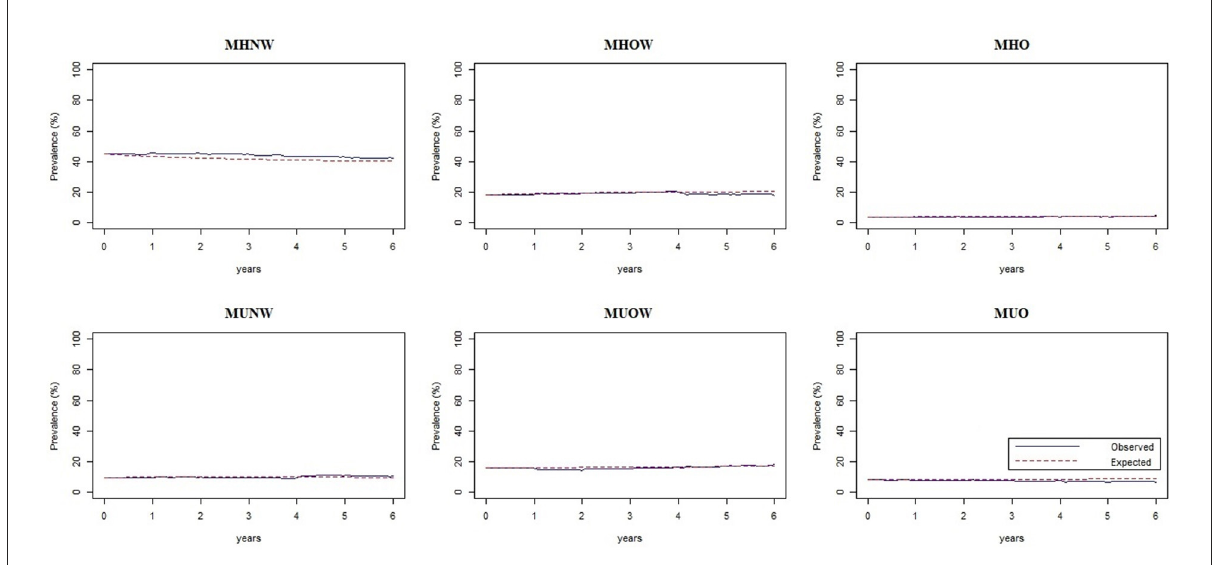
FIGURE5 Assessment plots of the multistate Markov model showing the observed and expected percentages of each phenotype against time. MHNW, metabolically healthy normal weight; MHOW, metabolically healthy overweight; MHO, metabolically healthy obesity; MUNW, metabolically unhealthy normal weight; MUOW, metabolically unhealthy overweight; MUO, metabolically unhealthy